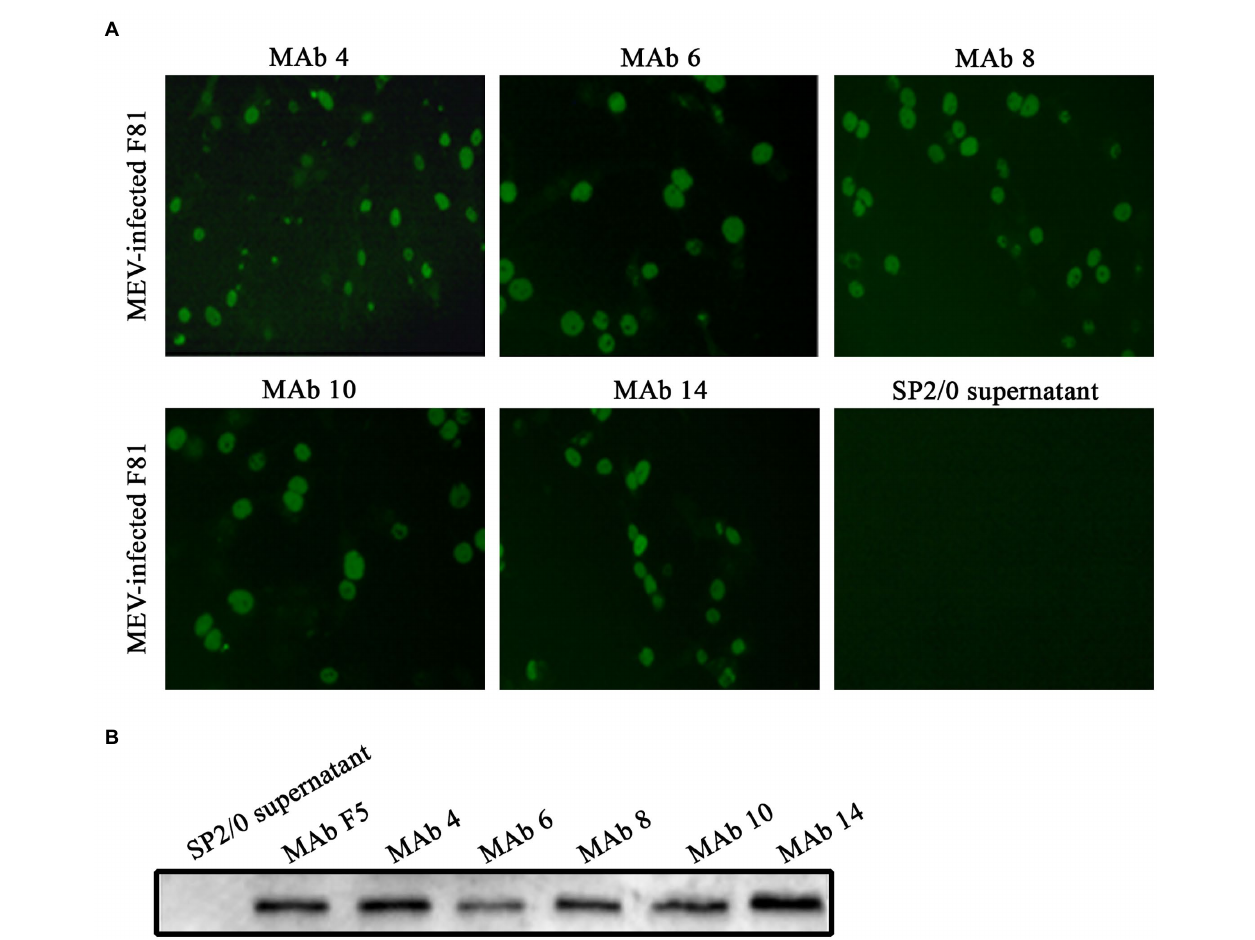
FIGURE 2 | Identification of MEV monoclonal antibody. (A) The immunofluorescence assay of MAbs against MEV in infected F81 cells (magnification, 100×). MEV- infected F81 cells were incubated with MAbs 4, 6, 8, 10, and 14 followed by FITC-conjugated secondary antibody. SP2/0 supernatant as a negative control. (B) The MEV VP2 protein was run for Western blotting using one of the MAbs 4, 6, 8, 10, and 14. SP2/0 supernatant and specific anti-MEV MAb F5 (Wang et al., 2009) served as negative and positive controls,